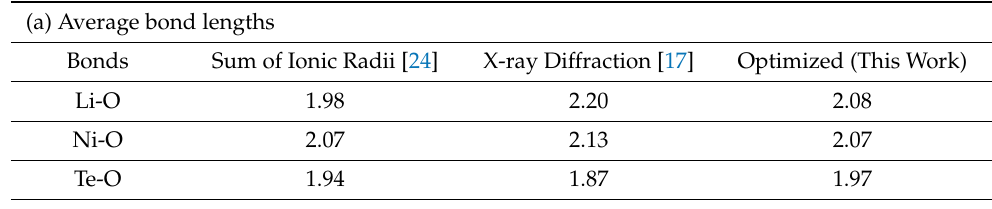
Table 2. Average lengths of the Li-O, Ni-O, and Te-O bonds and oxidation states of Li, Ni, Te, and O of Li 2 Ni 2 TeO 6